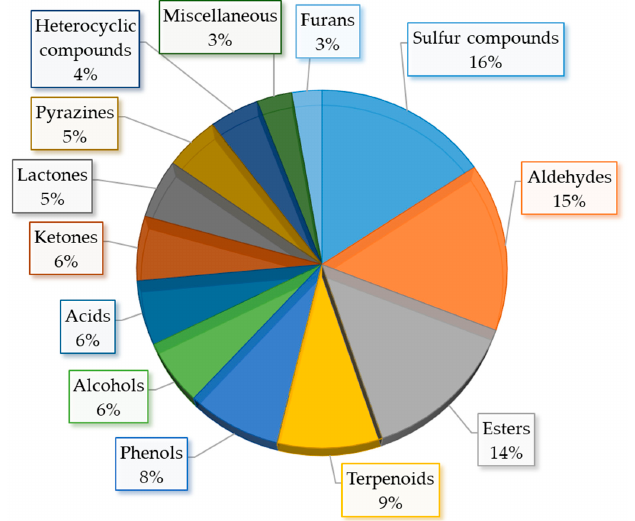
Figure 9. Key food odorants detected in food samples based on [97].